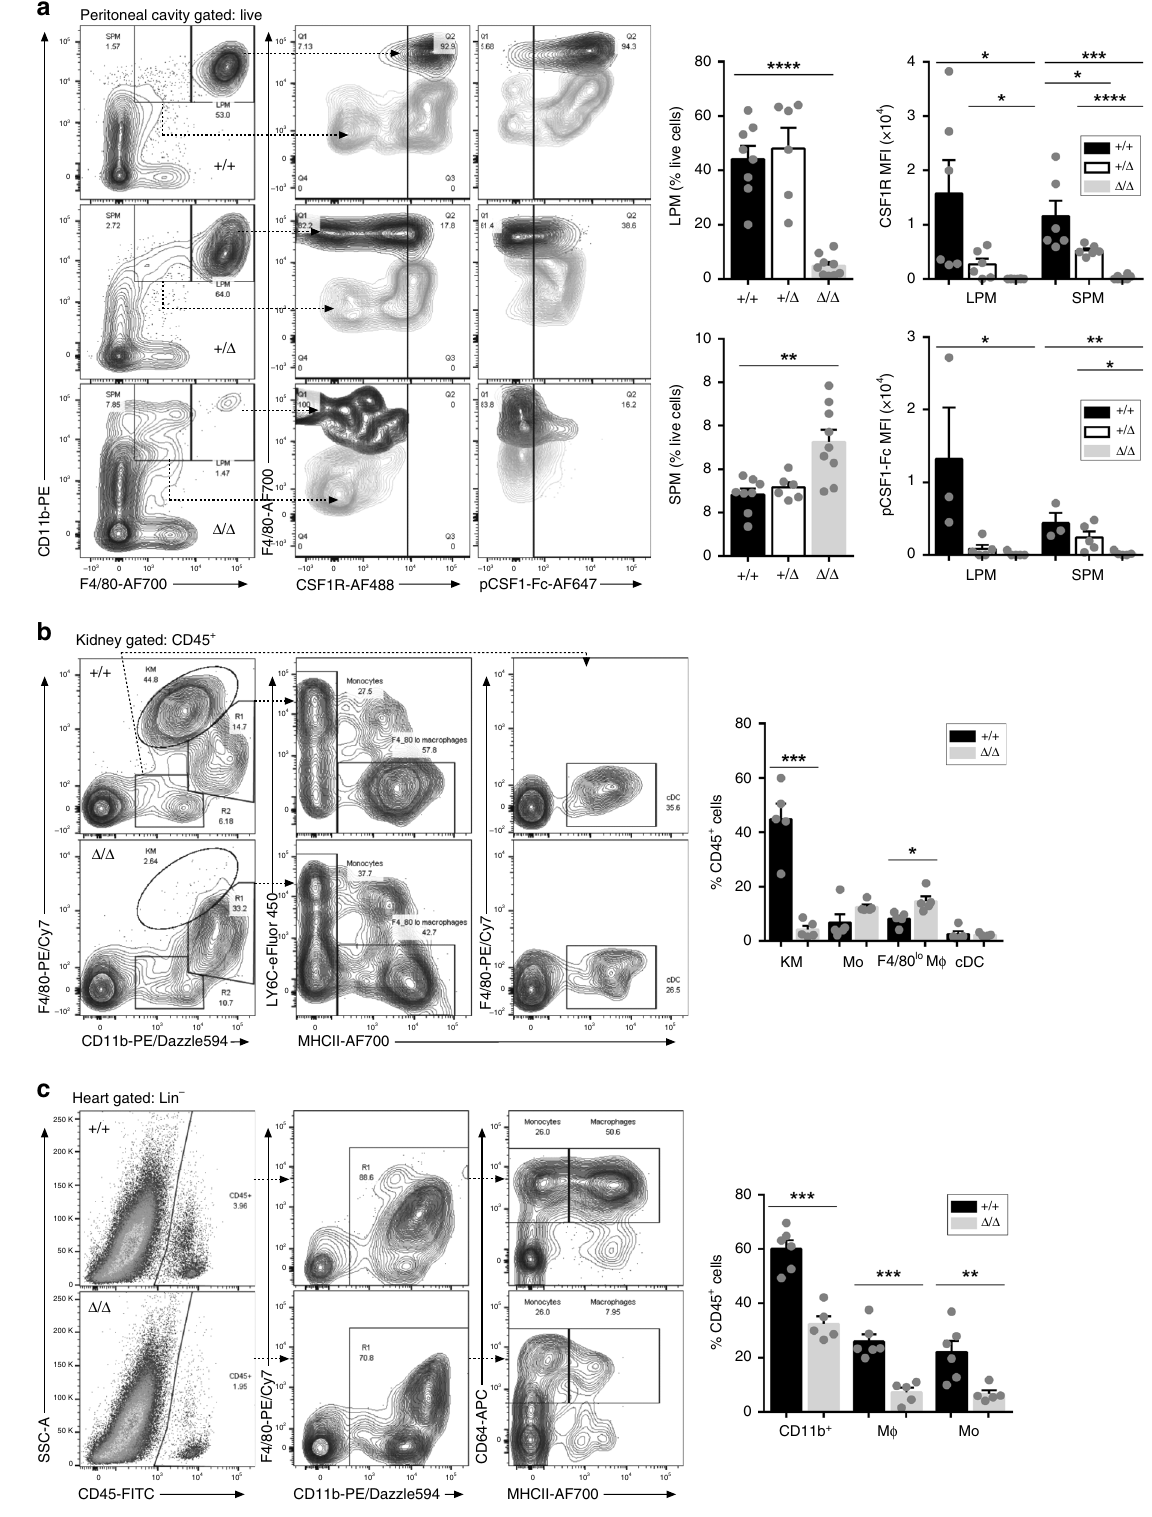
Loss of microglia in Csf1r Δ FIRE/ Δ FIRE mice . Microglia, the tissue-resident macrophage population of the brain, arise very early in mouse embryonic development and depend upon CSF1R signaling 44 . Microglia detected by localization of IBA1 or P2RY12 in littermate controls are absent in the brain of Csf1r Δ FIRE/ Δ FIRE mice (Fig. 7a, b). Disaggregation of the